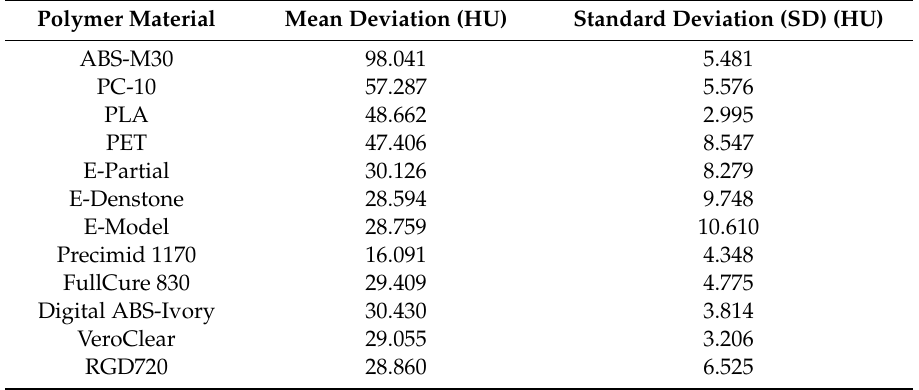
Figure 7. Histograms representing average results of the 12 mandible structures: ( a ) Digital ABS-Ivory material; ( b ) VeroClear material; ( c ) RGD720 material. Table 3. Statistical parameters representing average Hounsfield (HU) values of 12 mandible